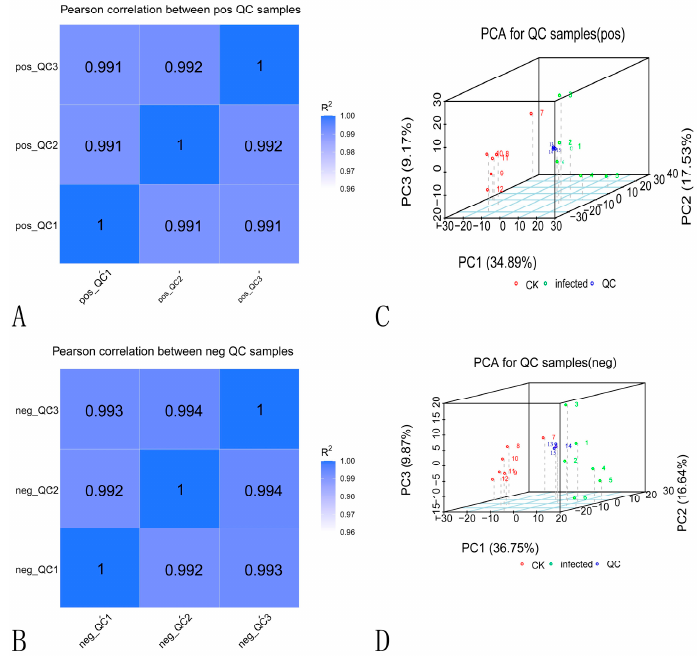
Figure 4. Data quality control chart. Note: ( A , B ) QC sample correlation analysis. ( C , D ) PCA analysis of QC samples.